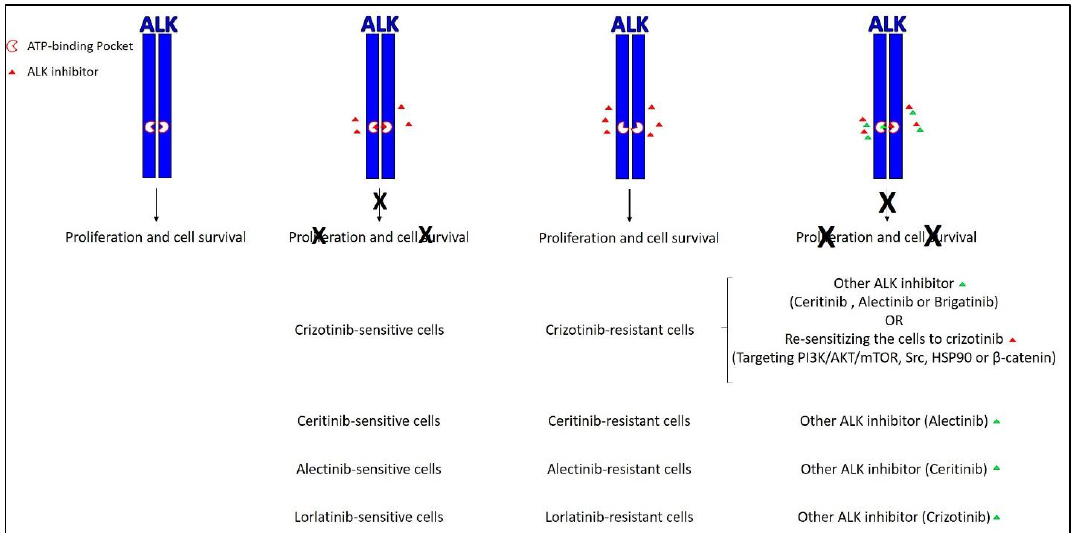
Figure 2. The current active approaches to overcome resistance to ALK inhibitors. The most common approach mainly relies on second and third generation ALK inhibitors such as ceritinib, alectinib, and brigatinib. The less common approach relies on re-sensitizing resistant cells to ALK inhibitors by targeting other signaling pathways. X represents the inhibitory effect of the ALK inhibitor. Green triangle represents the addition of another ALK inhibitor. PI3K: Phosphoinositide 3-kinase; HSP90: heat shock protein 90.